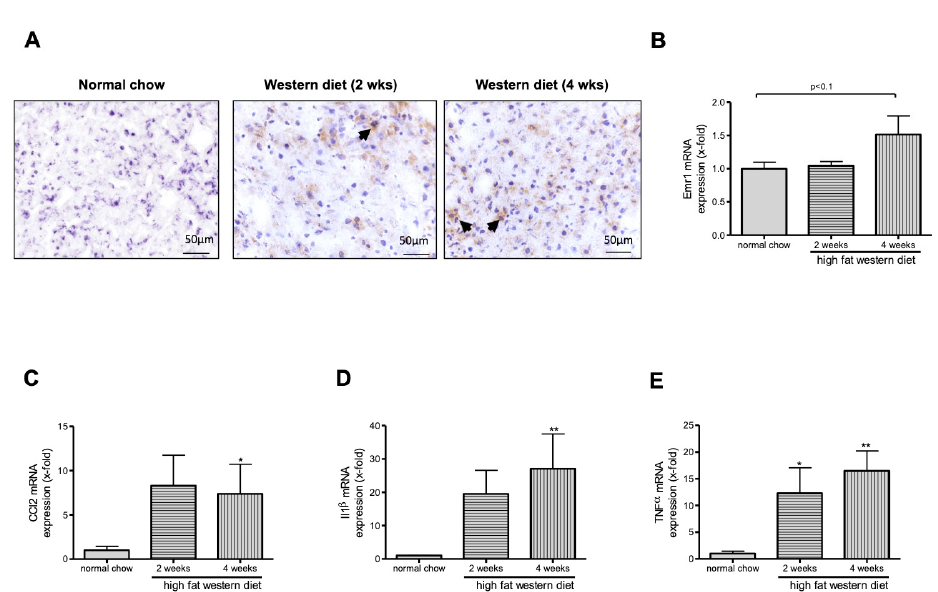
Figure 3. Hepatic assessment of macrophages and subgroup M1. ( A ) Hepatic frozen sections of TGR(mREN2)27 rats fed with normal chow, with 2 or 4 weeks of high fat Western diet were stained with the macrophage marker F4/80. Black arrow highlights positive cells. ( B ) Increased epidermal growth factor module-containing mucin-like receptor (Emr1) expression suggests increased numbers of macrophages after 4 weeks of WD feeding. ( C ) Increased expression of in CC-chemokine ligand 2 (Ccl2) was noticed after 4 weeks of WD feeding. ( D , E ) mRNA level of Il1 β and TNF α confirmed the inflammatory effect after 2 and 4 weeks of WD feeding. */** p < 0.05/0.01 vs. normal chow.